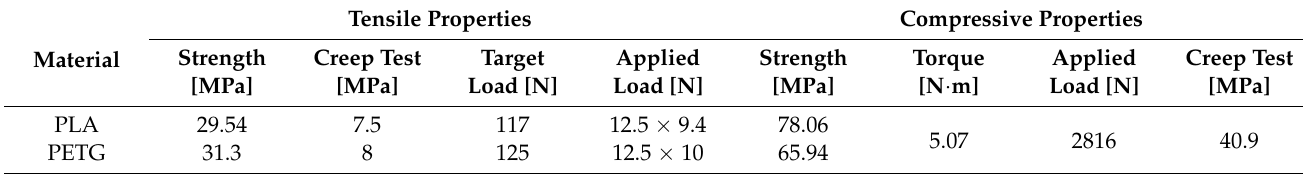
Table 5. Loads used for creep testing.